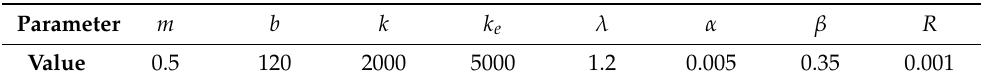
Figure 7. Schematic of the experimental platform.